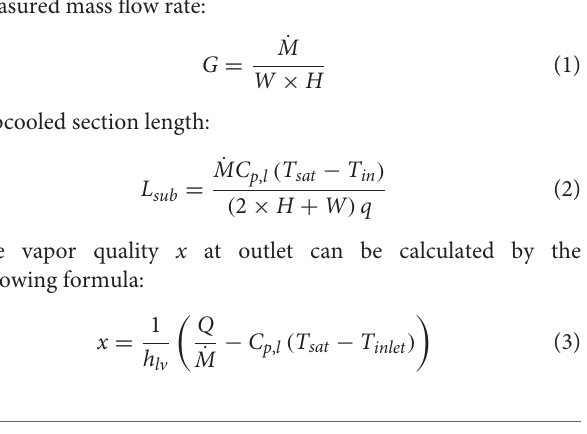
FIGURE 1 | Schematic diagram of the experimental apparatus.